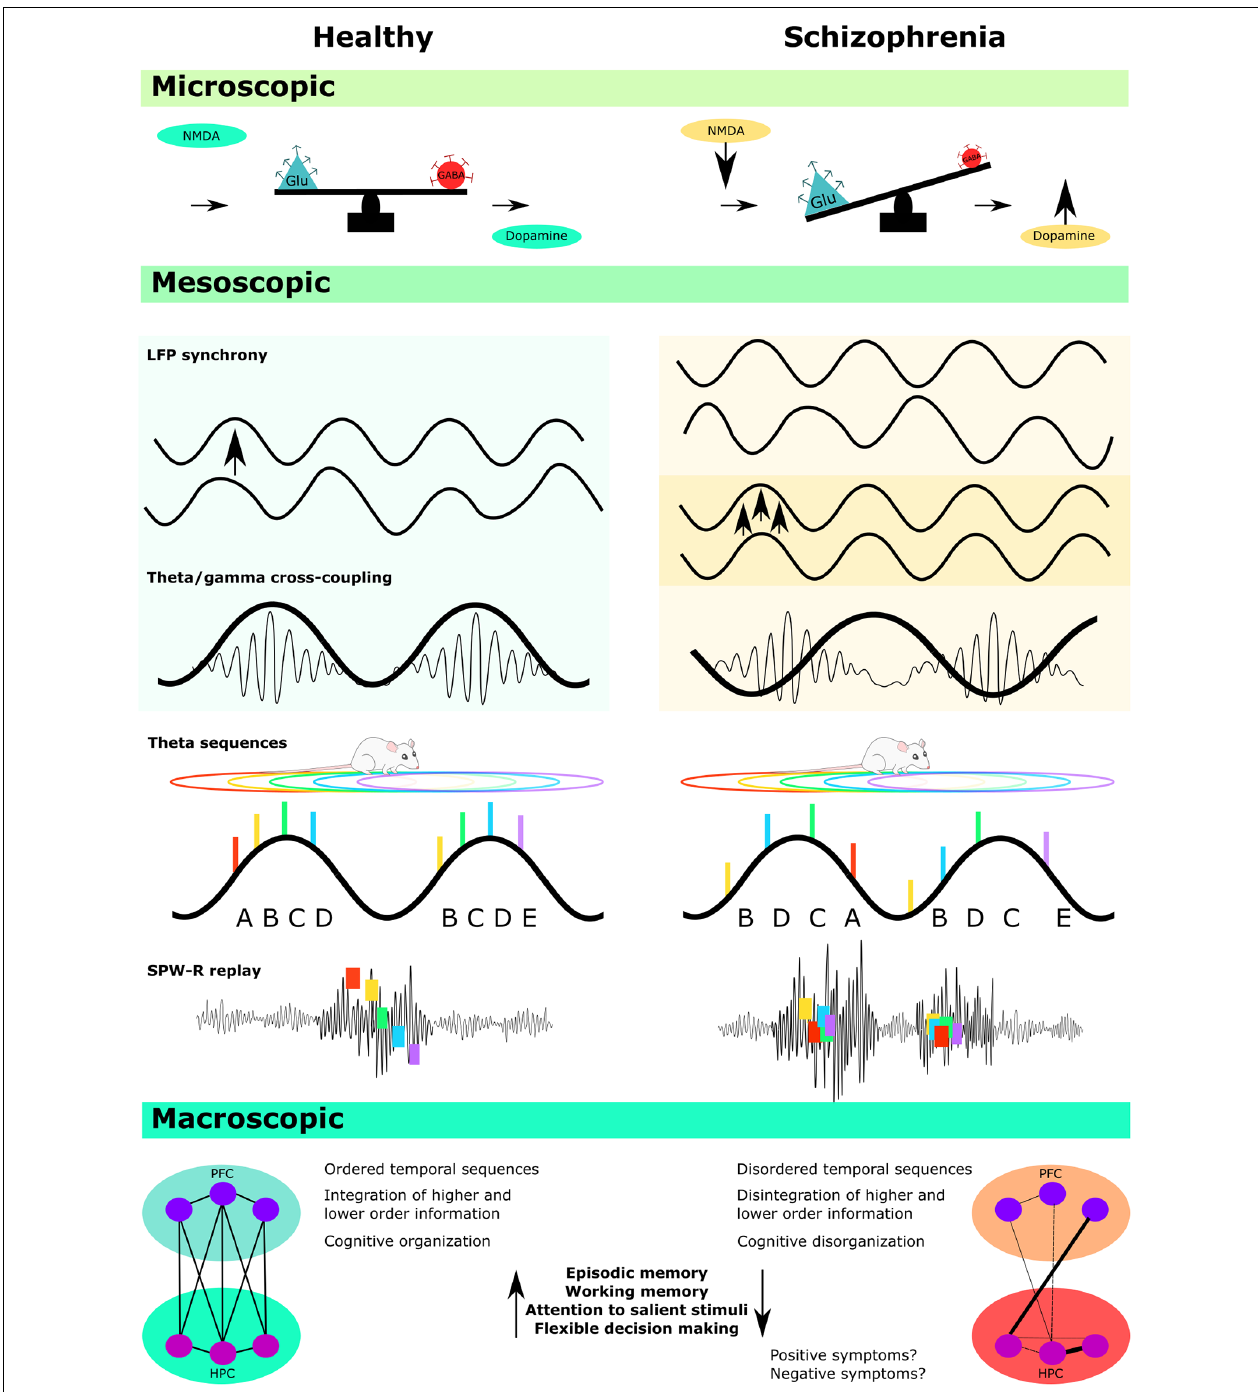
FIGURE 2 | Disorganized oscillatory activity provides the mesoscopic link between microscopic disruptions at the cellular and molecular level, and macroscopic outcomes for impaired cognition in schizophrenia. At the microscopic level, hypofunction at the site of NMDA receptors leads to an imbalance of excitatory/inhibitory regulation in schizophrenia. This in turn is thought to lead to dysregulation of dopamine transmission, with hyperdopaminergic activity predominant in sub-cortical regions. At the mesoscopic level, local field potential (LFP) synchrony is disturbed across several frequency bands, including theta and gamma. This can manifest as a desynchronized activity within and between hippocampal and prefrontal regions, and disturbed theta/gamma cross coupling. A failure to coordinate the spiking of single cells relative to the hippocampal theta rhythm also leads to disordered theta sequences and diminished neural syntax across multiple theta cycles, as well as a loss of structured replay activity during sharp-wave ripples. Finally, at the macroscopic level, these disturbances are thought to contribute to functional dysconnectivity across distributed networks. At the cognitive and behavioral levels, this manifests as diminished performance across a range of tasks.